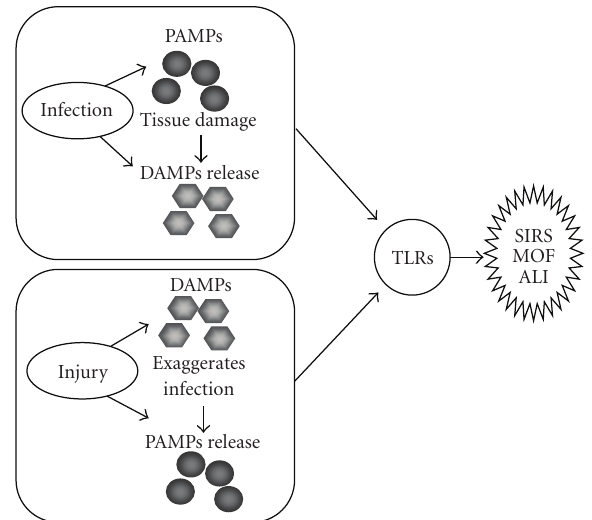
Figure 1: Role of TLRs in mediating inflammation and organ injury. Infection not only causes PAMPs release, but also causes tissue and cell damage along with subsequent DAMPs release. Similarly, injury caused by trauma or various other factors not only leads to DAMPs release but also renders the patient more susceptible to infection and therefore PAMPs release. In turn, PAMPs and DAMPs act through TLRs to activate the innate immune system, yet they can also contribute to persistent and deleterious systemic inflammation and organ injury, including